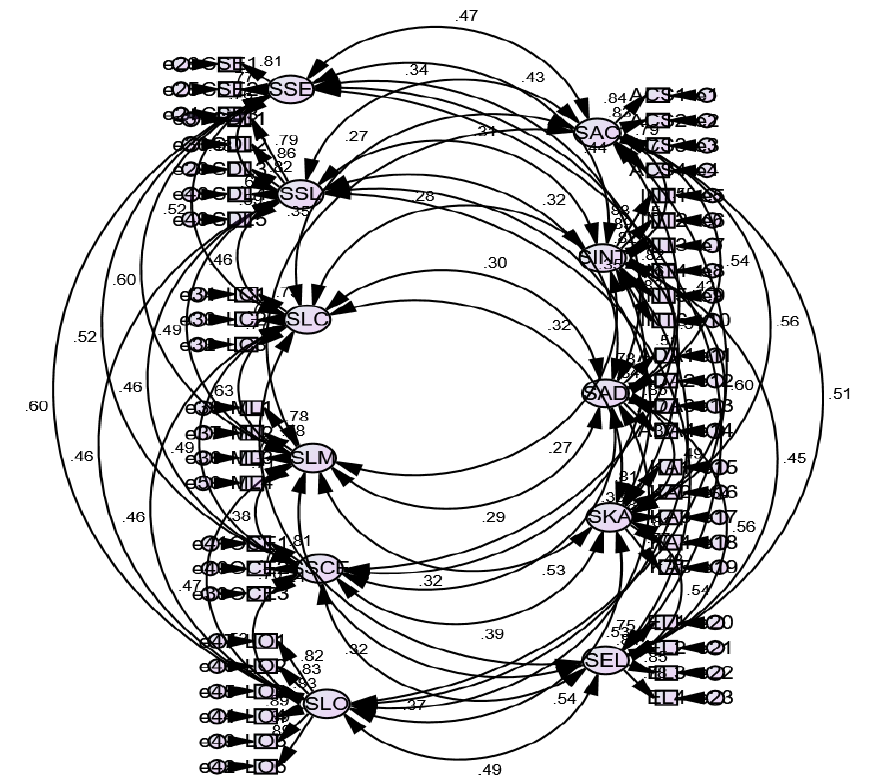
Figure 2. First order measurement model for student-level constructs (Eleven-factor measurement model).